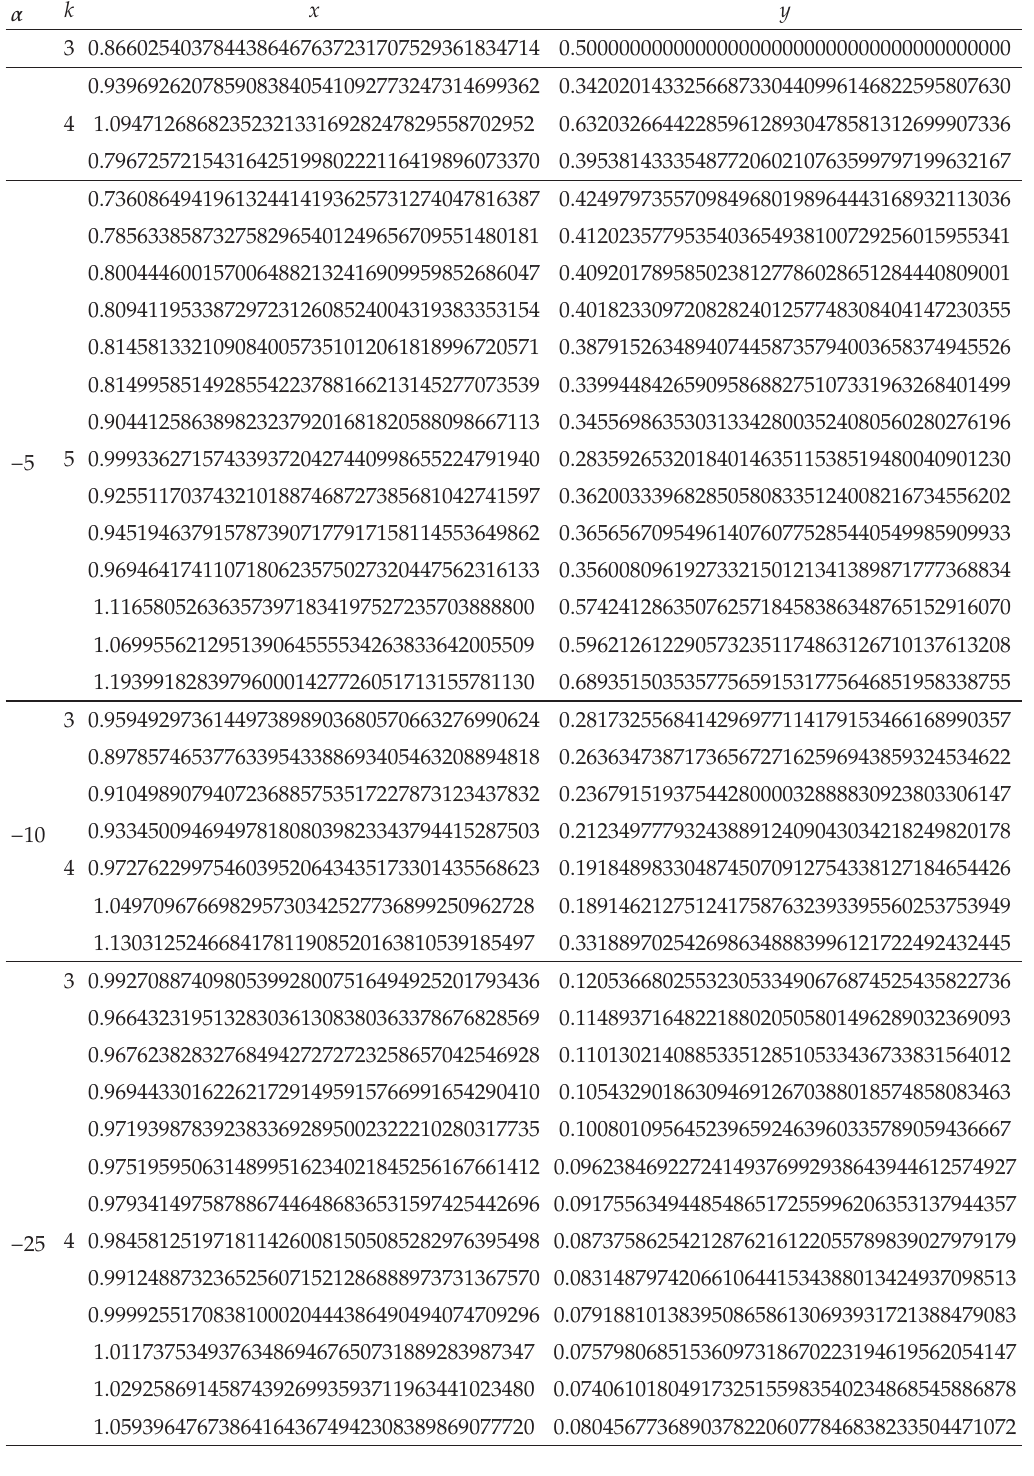
Table 2: Typical coordinates (cid:2) x,y (cid:4) of periodic regions’ centers in general M-sets for α (cid:3) − 5 , − 10 , −